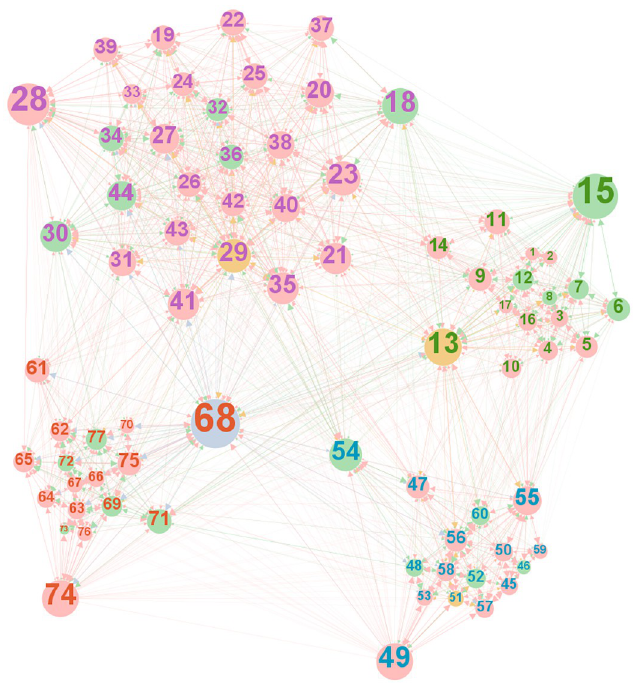
Fig 2. Organizational network of the R&D section of a manufacturing